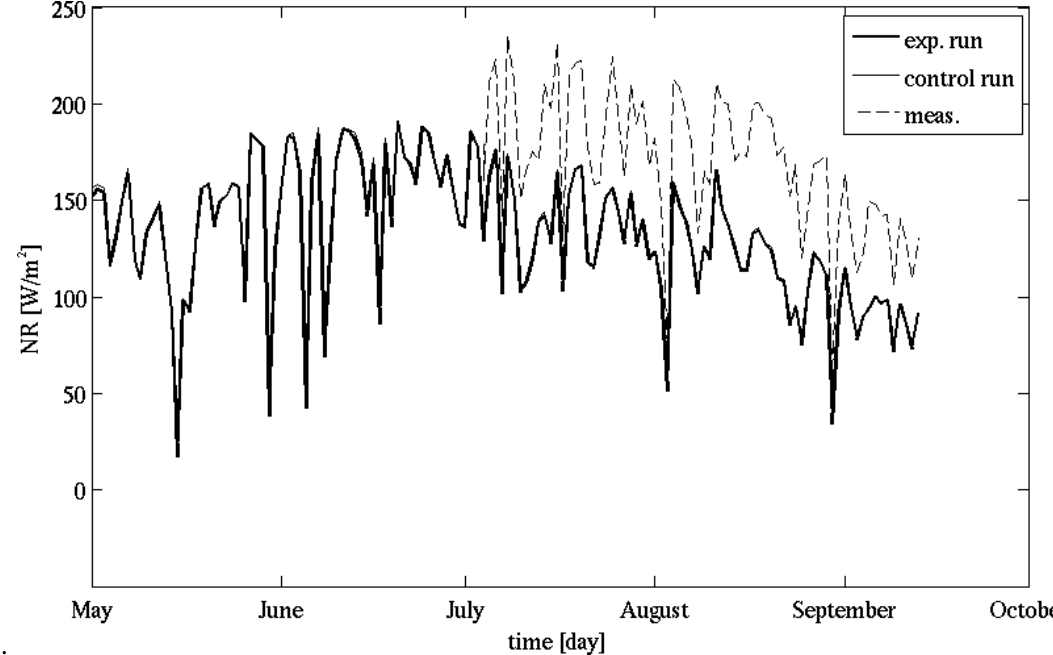
Figure 10. Mean daily values of net radiation (in Wm - 2 ) during the 2009 vegetative season. The dashed line shows the measurements carried out on the flank of the vineyards, while the thick line refers to the experimental run and the thin line to the control run.